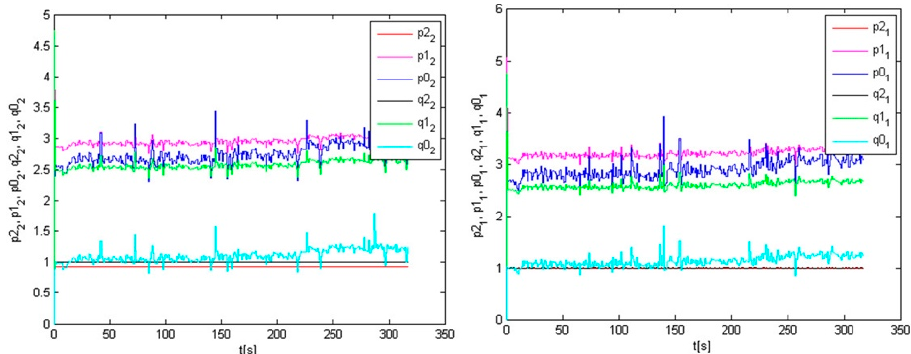
Figure 12. Output of control.